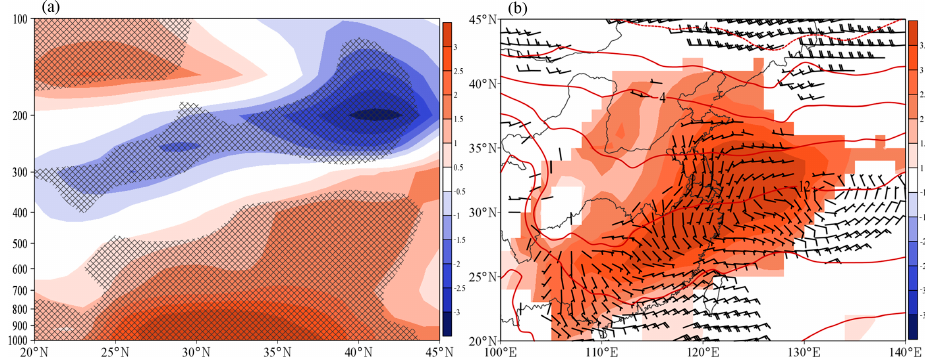
Figure 7. ( a ) The vertical section of composite standard anomalies of air temperature across 120° E. The crossed area in each panel denotes anomalies exceeding the 0.01 significance level. ( b ) The composite of original winds (Only anomalies exceeding the 0.01 significance level are shown as shafts; units: m·s − 1 ), original temperature (contours, units: °C) and standard anomalies of temperature advection (Only the composite standard anomalies exceeding the 0.10 significance level are shaded) at 925 hPa.